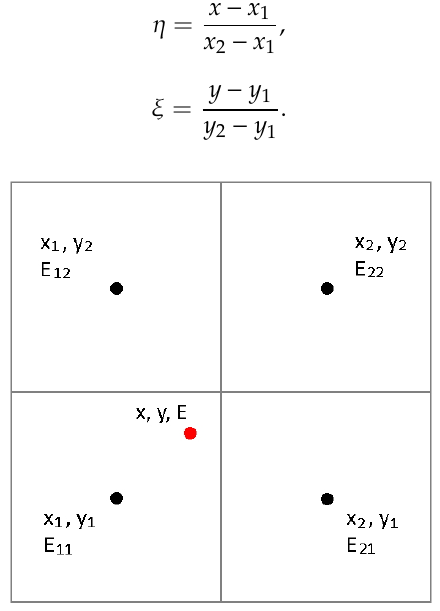
Figure 12. Calculation of the elevation of a point with Bilinear Interpolation.